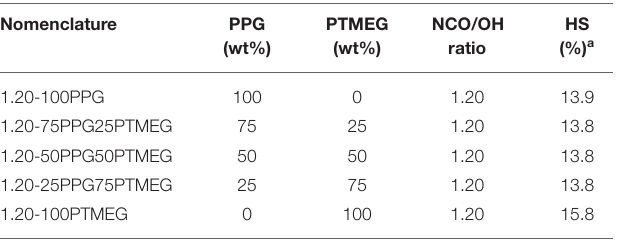
TABLE 5 | Nomenclature and composition of the poly(ether-urethane)s synthesized with different PPG + PTMEG blends.